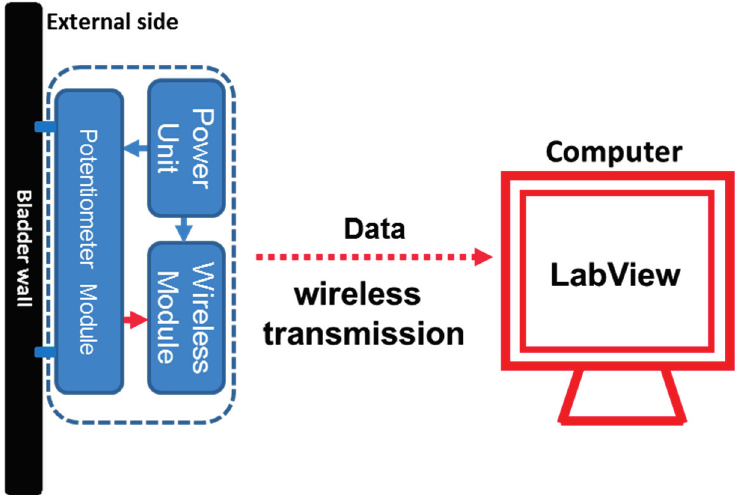
Figure 1. Schematic representation of the prototype potentiometric device for bladder volume monitoring. The power unit supplied a stable, constant 3-mA current to the flexible potentiometer and Bluetooth wireless transmission modules. The two ends of the flexible potentiometer were fixed to the outer bladder wall, where the resistance value of the potentiometer changed on the basis of changes in the bladder wall length. Then, the Bluetooth wireless transmission module, an Arduino Nano 3.0, sent the digital data to an external receiver of a computer via wireless transmission. The received data were further processed using the LabVIEW program, and the bladder capacity information was displayed on the computer screen in real